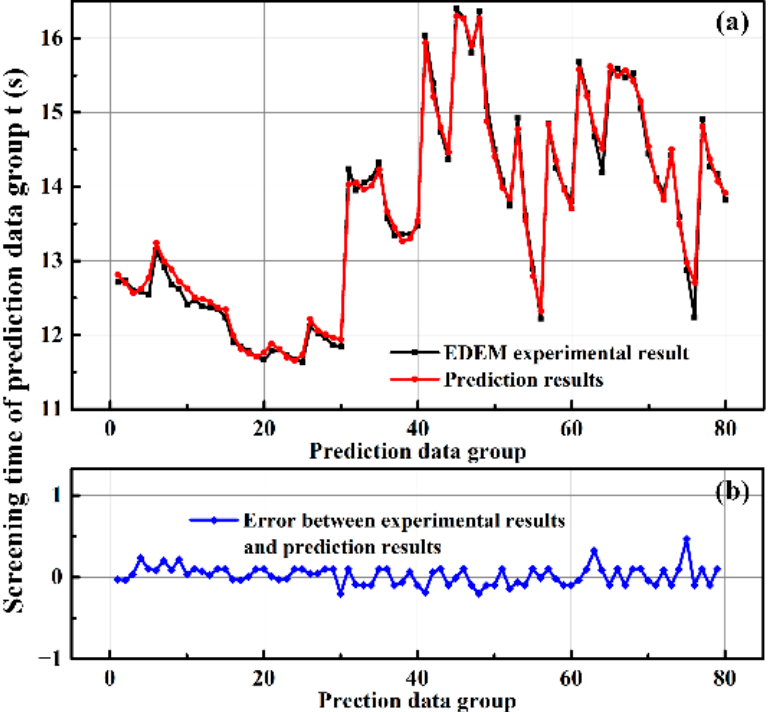
Figure 15. Comparison of screening time between the prediction and experiment. ( a ) prediction results, and ( b ) error results.